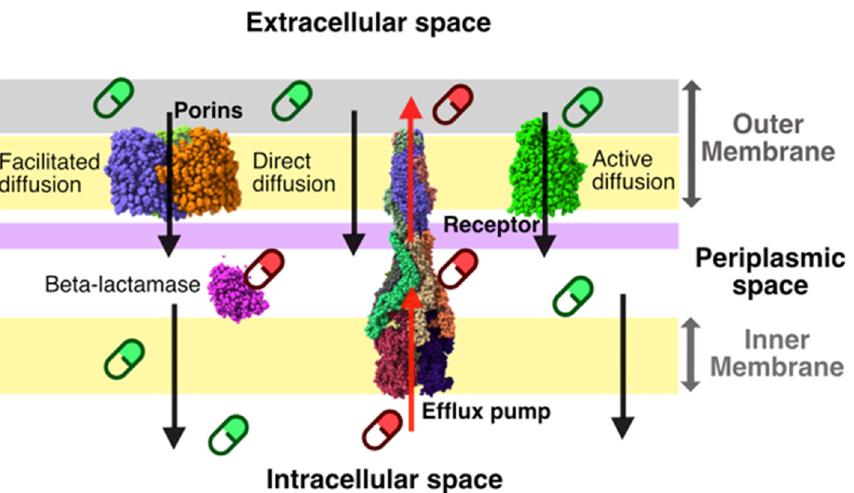
Figure 1. Compound accumulation process. Successful (green) versus unsuccessful (magenta) compounds.